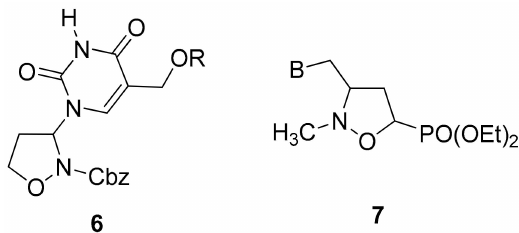
Figure 2. New synthesized modified pyrimidines as potential antiviral